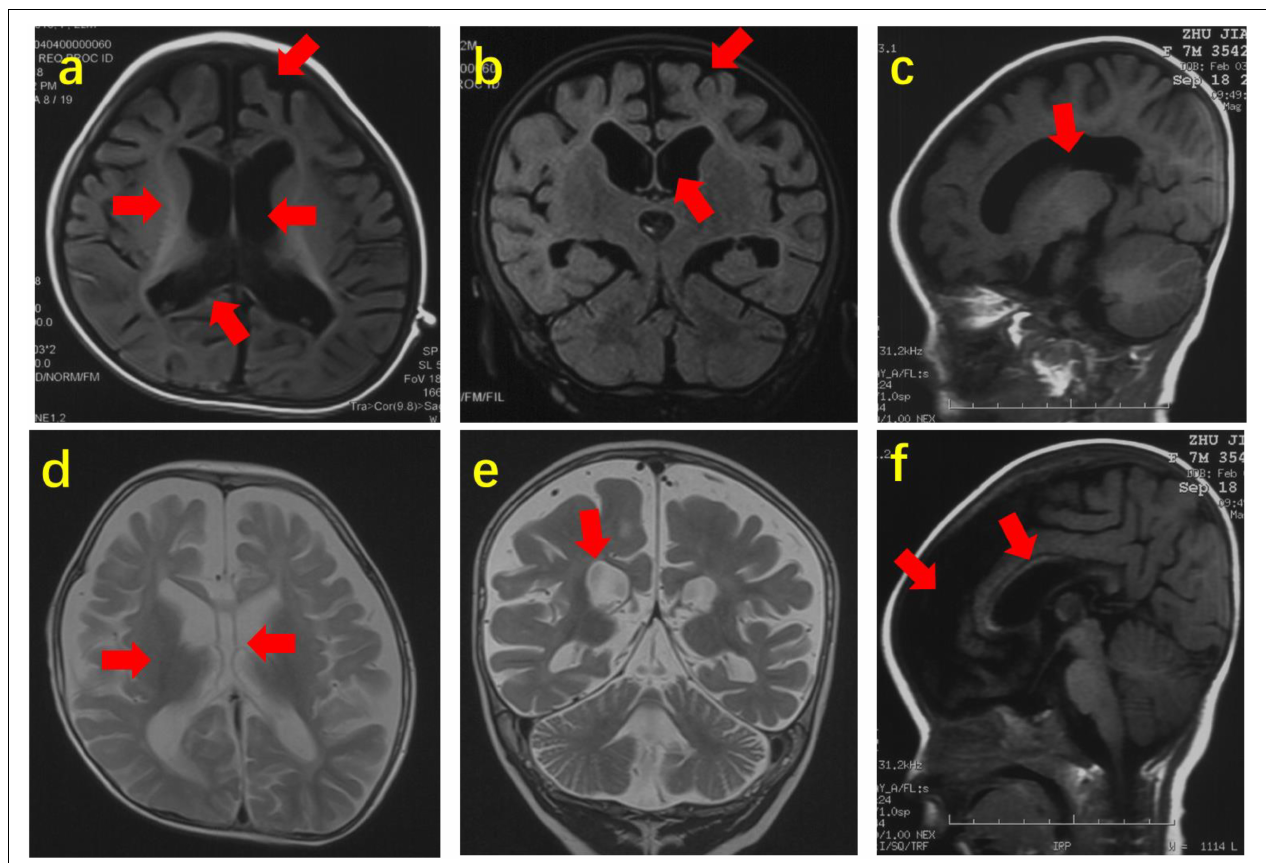
FIGURE 2 | Abnormal brain MRI of 3 patients with SCN2A variants. Brain MRI of Patient 14 at the age of 22 months. (a,b) . Axial and coronal images (T1WI) showing agenesis of corpus callosum, delayed white matter myelination, dysplasia of frontotemporal lobes and enlargement of lateral ventricles. Brain MRI of Patient 29 at the age of 7 months. (c,f) Sagittal images (T1WI) showing enlargement of lateral ventricles, agenesis of corpus callosum and dysplasia of frontotemporal lobes. Brain MRI of Patient 39 at the age of 12 months. (d,e) Axial and coronal images (T2WI) showing agenesis of corpus callosum, delayed white matter myelination and enlargement of lateral ventricles. The arrow points to the